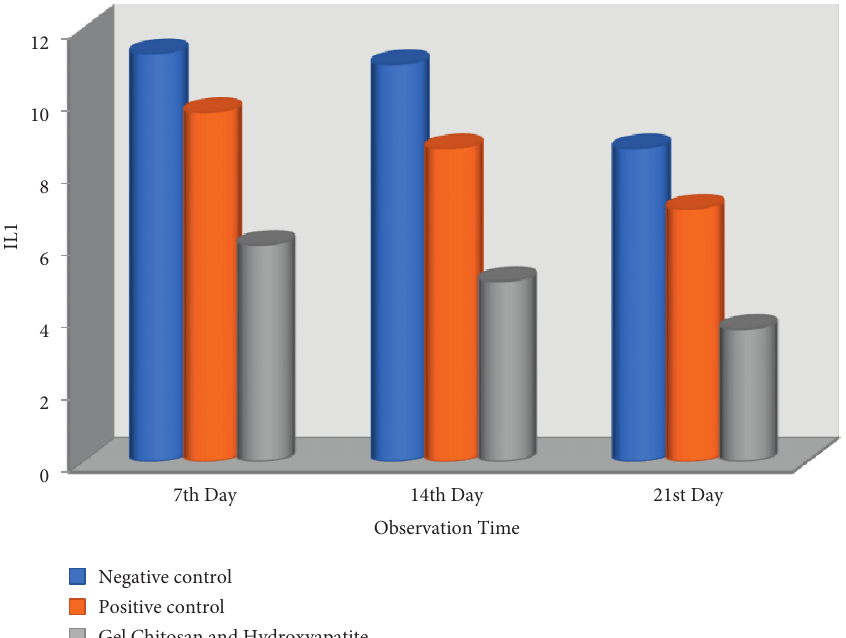
Figure 5: Bar chart of IL-1 expression between treatment